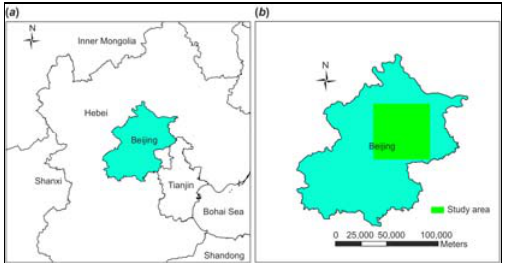
Figure 2. Overview of study area, (a) location of Beijing within the People's Republic of China, (b) location of the study area within